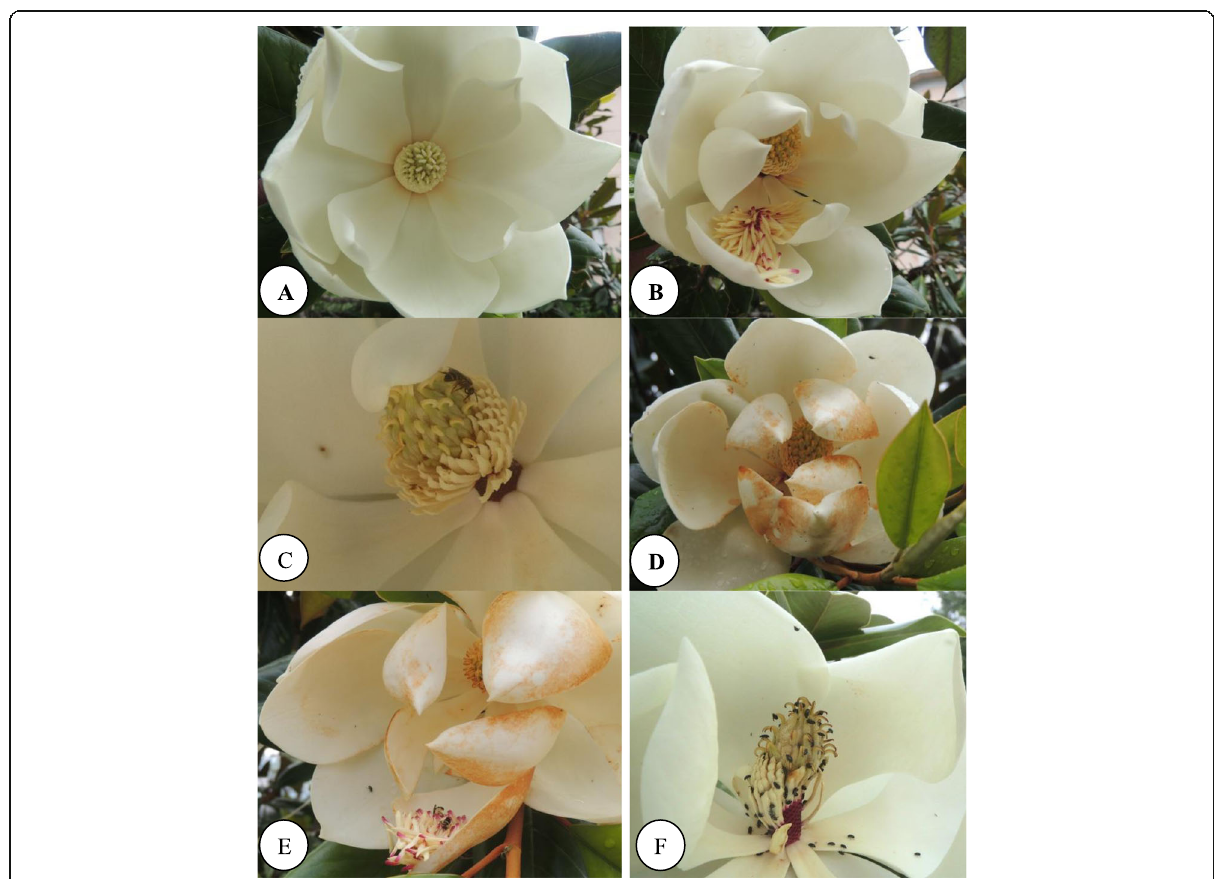
Fig. 1 Dianthesis and activities of floral visitors in M . grandiflora . a First flower opening, protogynous stigmas were exposed. b Second flower opening, anthers have started to dehisce. c Bees ( Apis melifera ) crawling on stigma resulting self-pollination. d Numerous thrips collecting dusted pollen from petals. e Two bees ( Apis melifera ) and beetles collecting pollen from the dehisced anthers over the petals. f Several beetles collecting pollen and feeding stigma secretions resulting